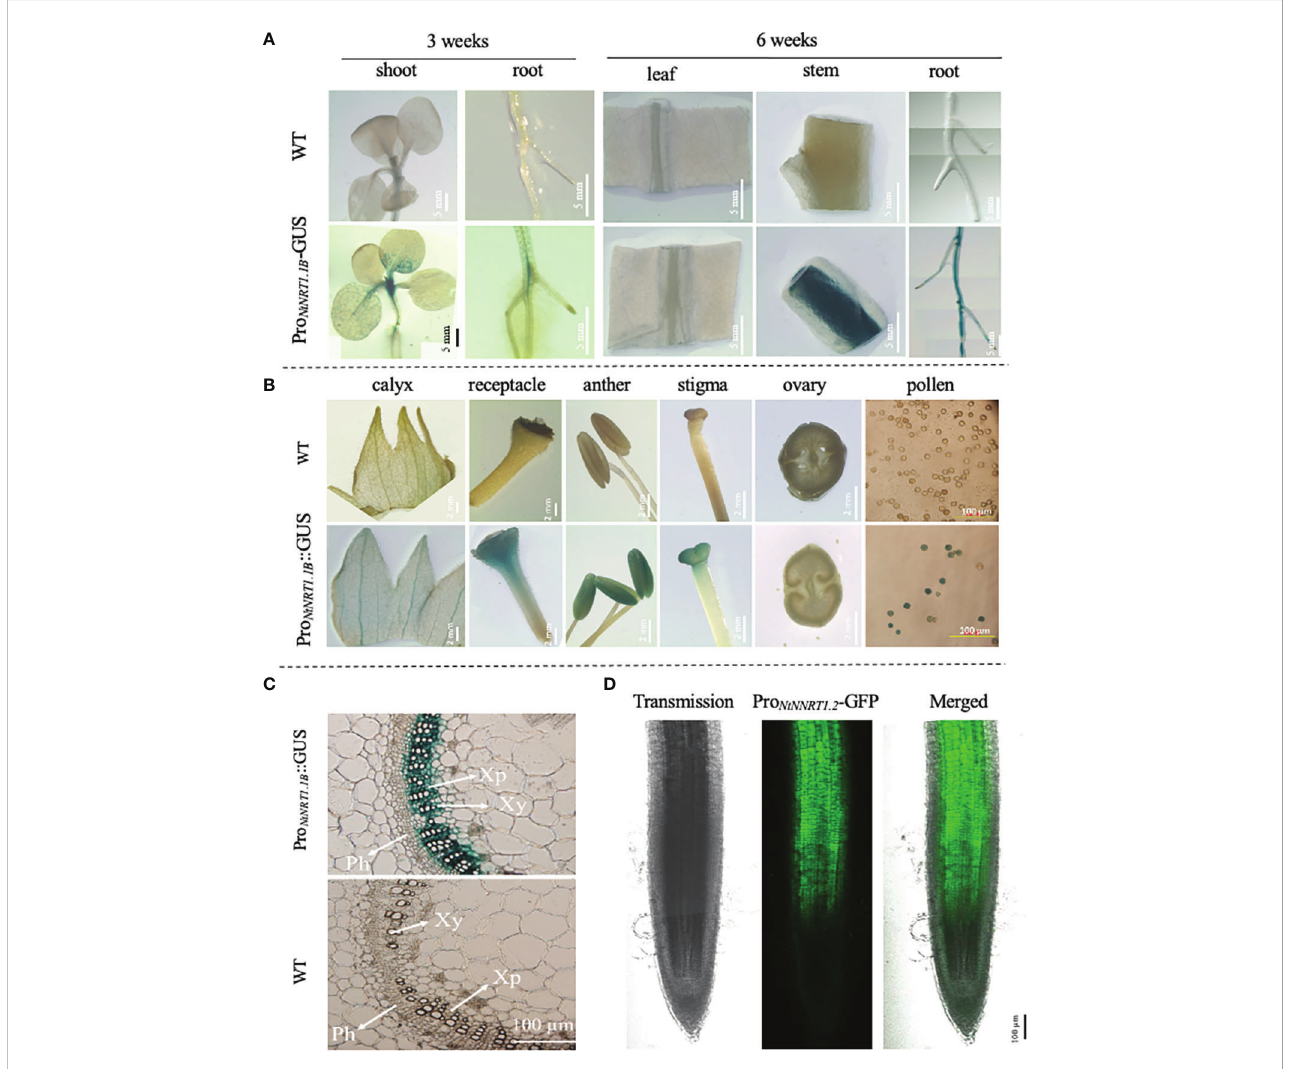
FIGURE 3 Analysis of promoter activity of the NtNRT1.1B gene in tobacco lines transformed with Pro NtNRT1.1B - b -glucuronidase ( GUS ) or -green fl uorescence protein (GFP). A genomic sequence 2,000 bp upstream from a putative start codon of NtNRT1.1B was cloned before the GUS or GFP marker gene, and then transformed into tobacco plants (K326) to create different transgenic lines generated for promoter activity assay under normal or confocal microscopy (see Materials and methods). (A, B) Observation of GUS activity in the various tissues of the Pro NtNRT1.1B - GUS transgenic tobacco during a vegetative stage, i.e., 3 or 6 weeks ’ growth (A) and reproductive stage (B) . (C) Detection of GUS activity in a cross-section of stems of 6-week-old tobacco plants. Plants were grown hydroponically with 1 mM NH 4 NO 3 as the N source. Similar expression patterns of GUS driven by Pro NtNRT1.1B were observed in